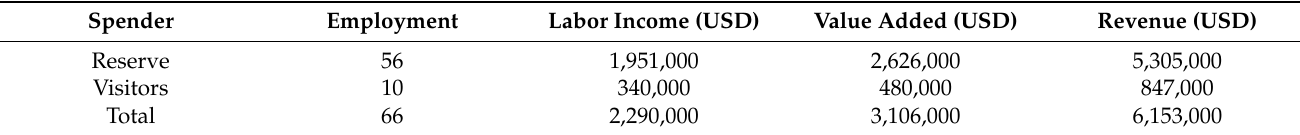
Table 8. Estimated annual contributions to employment, labor income, value added, and revenue by South Slough Reserve. Spender Employment